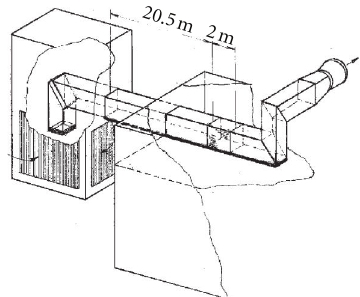
Figure 1: The scheme of the open low-speed wind